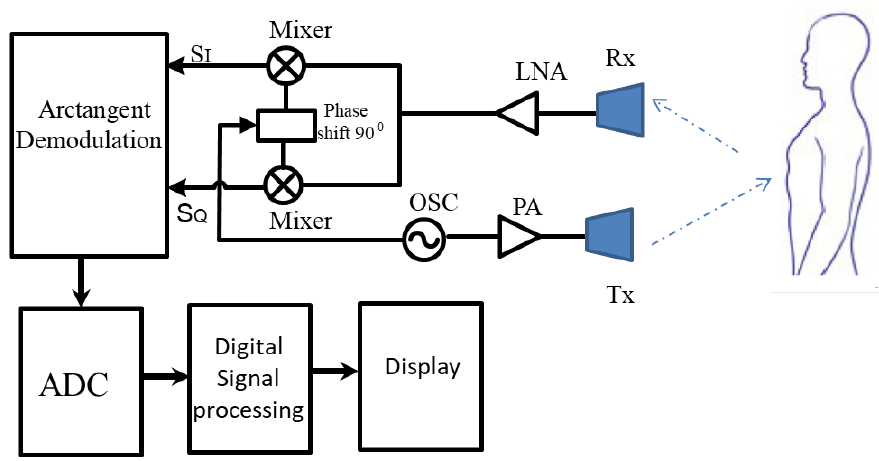
Figure 5. Continuous wave system